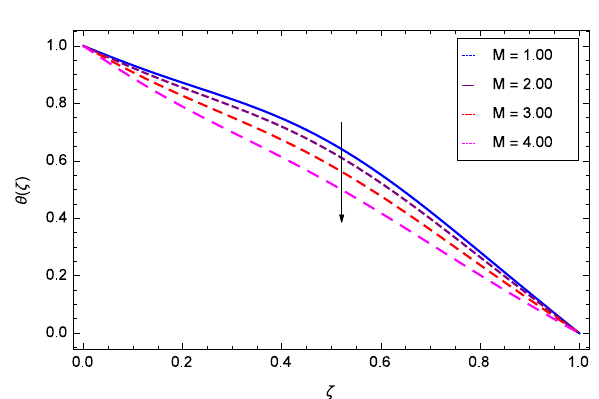
Figure 12. Analysis through upper disk stretching parameter k 3 and tangential velocity g ( ζ ).